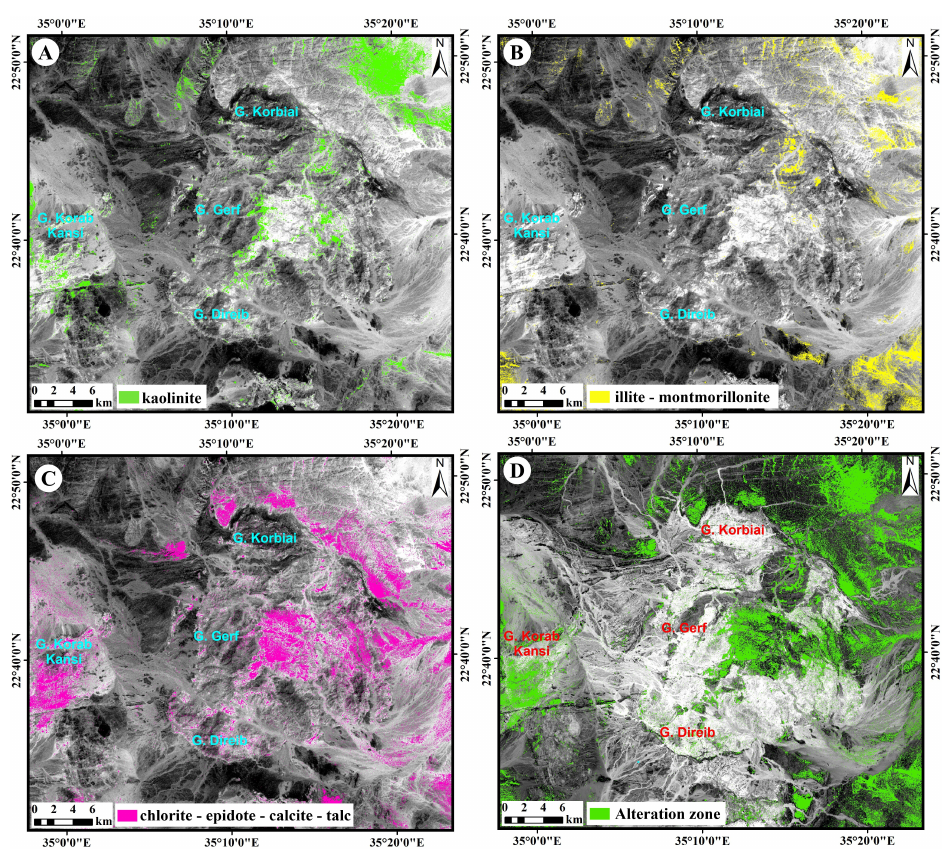
Figure 10. The surface abundance of alteration zones resulted from CEM mineral mapping technique ( A ) argillic (kaolinite), ( B ) phyllic (illite-montmorillonite, ( C ) propylitic (chlorite-epidote-calcite-talc) and ( D ) the grouped alteration zones in the study area.